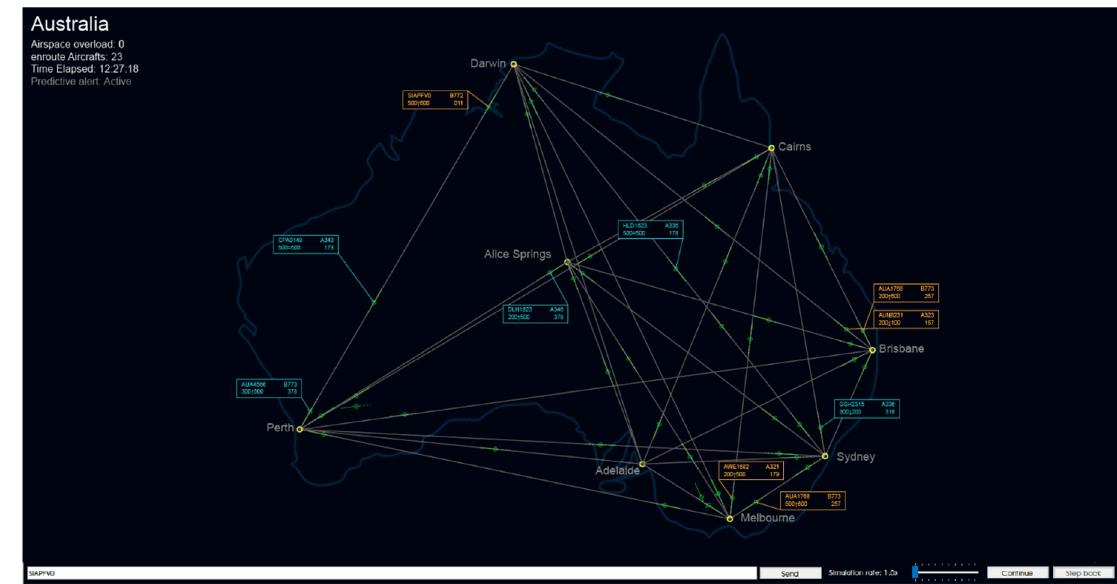
Figure 17. Silent mode interface concept.